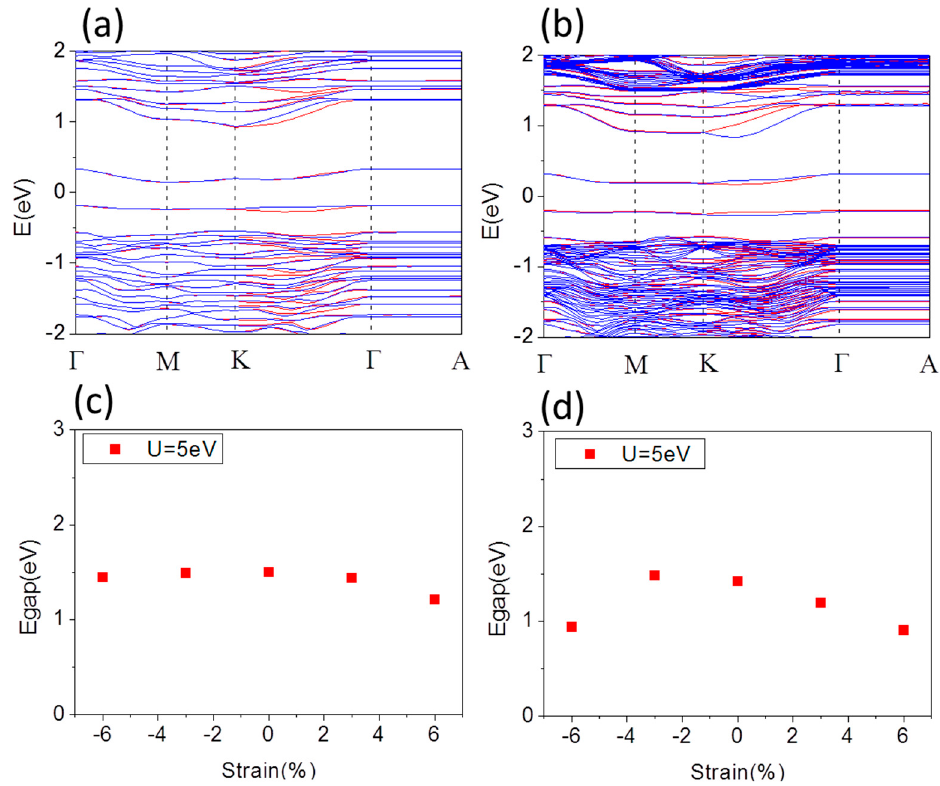
Figure 3. Band structure of O terminated α -Fe 2 O 3 : 1 × 1 × 1 film ( a ); and 1 × 1 × 3 film ( b ), for lattice constant a = 5.035 Å at U = 5 eV. Band gap of O terminated α -Fe 2 O 3 : 1 × 1 × 1 film ( c ); and 1 × 1 × 3 film ( d ), as a function of strain.